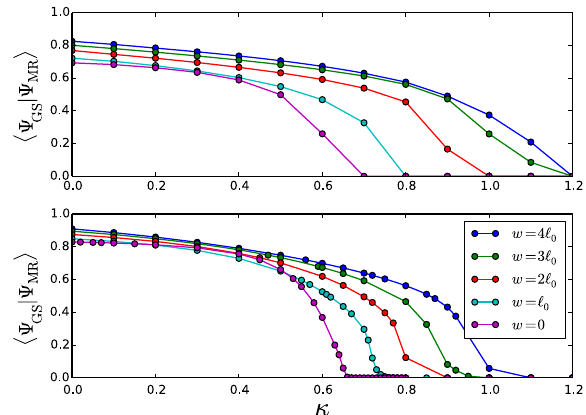
FIG. 4. Energy gap (energy difference between the two lowest states) and model wave-function overlap ( N Φ ¼ 33 system) at the MR Pfaffian ( N e ¼ 18 ) and aPf ( N e ¼ 16 ) shifts. Note that for small κ , both the gap and overlaps are higher for the MR Pfaffian than they are for the aPf.